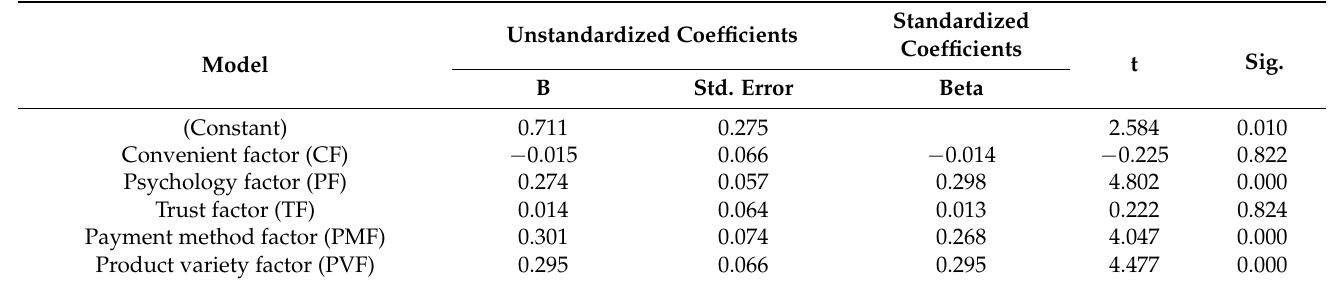
Table 5. Regression